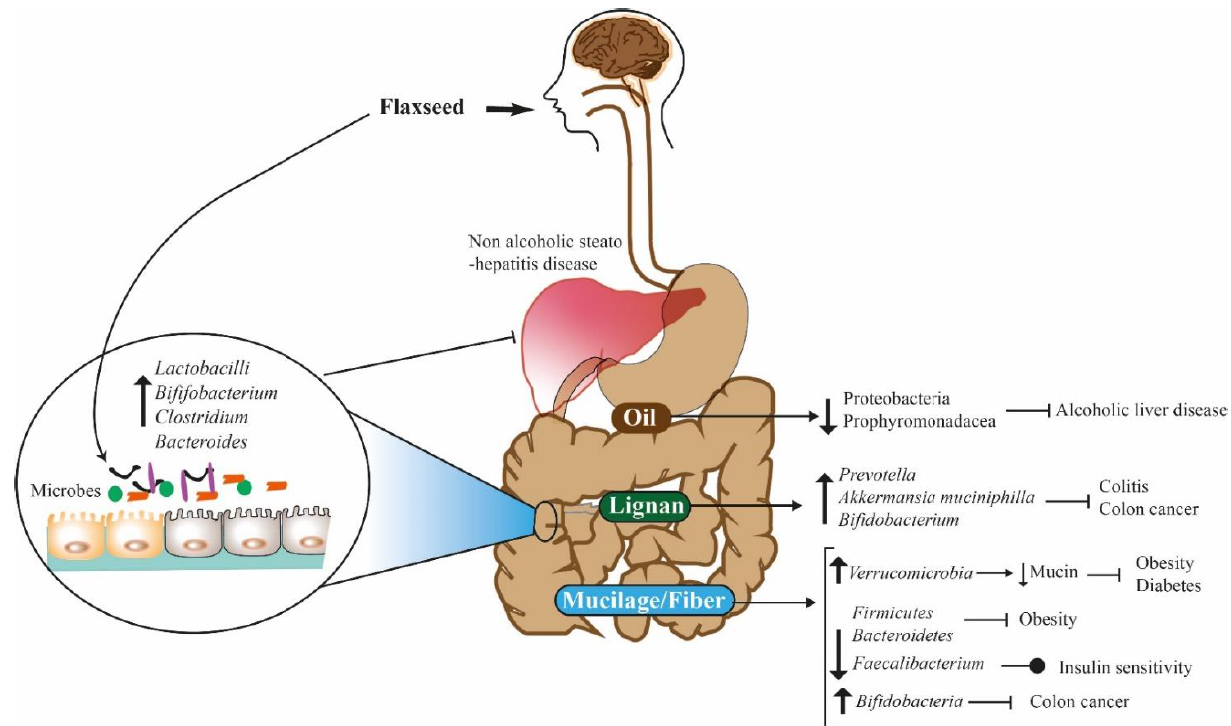
Figure 3. Effect of flaxseed components and gut health.